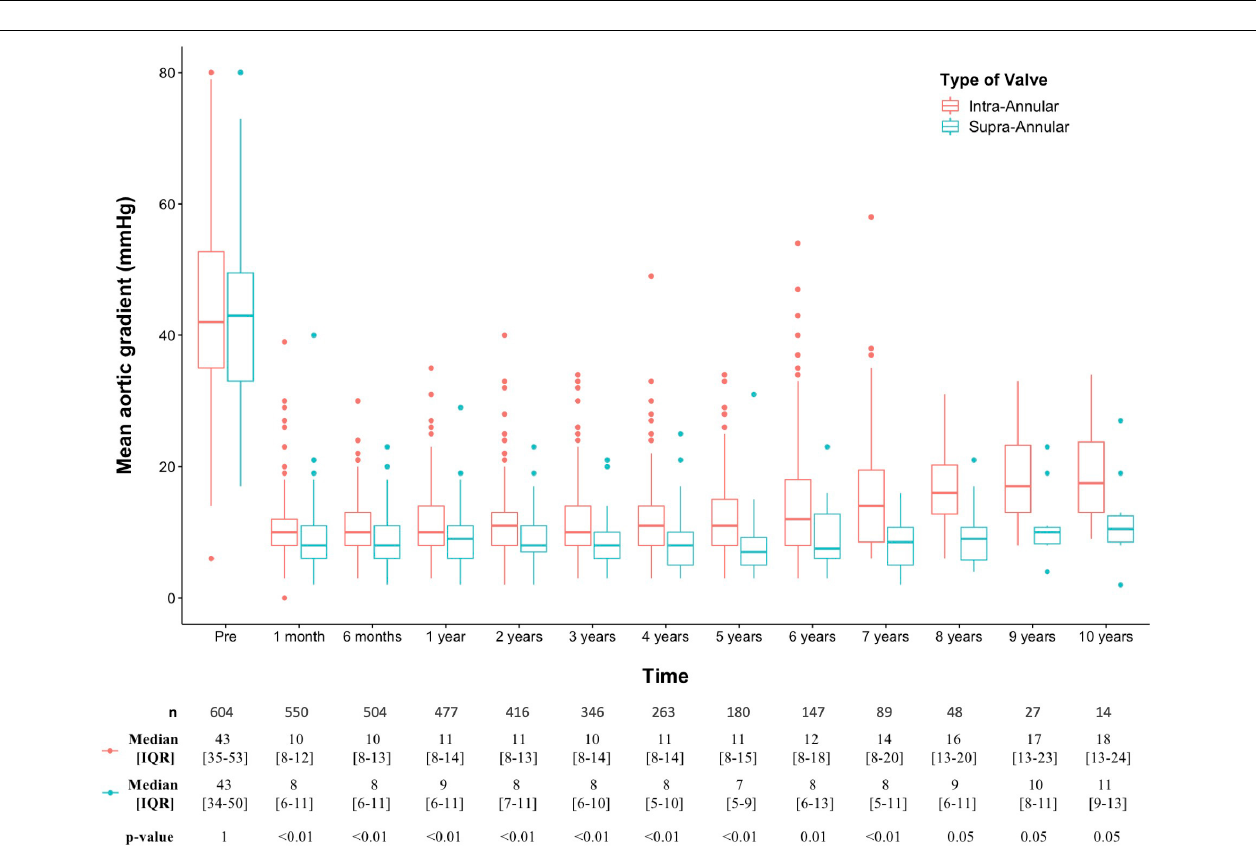
FIGURE 2 | Pairwise analysis of intra-annular versus supra-annular transaortic mean gradients at each follow-up time; p values were adjusted using the Bonferroni multiple testing correction method and obtained with Wilcoxon rank sum test. IQR, interquartile range; SD, standard deviation.